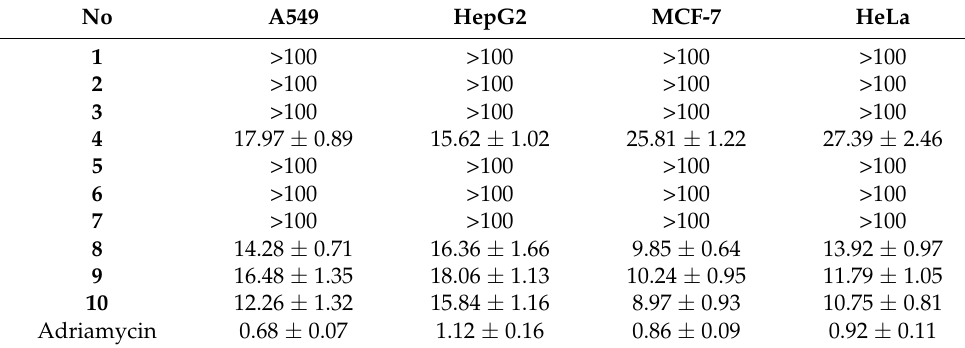
Table 4. Cytotoxic activity of compounds 1 – 9 , (IC 50 , µ M) a